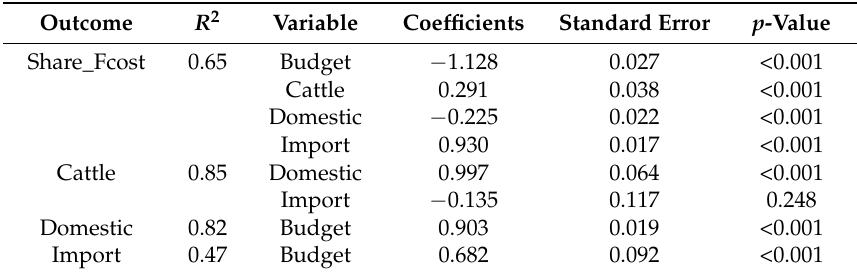
Table 2. Path model